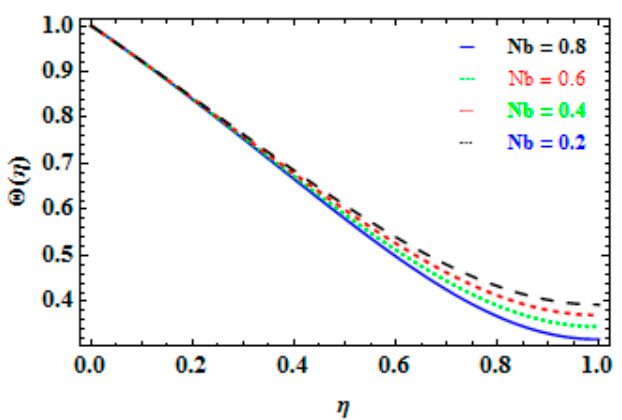
Figure 13. Influence of β on Θ ( η ) .